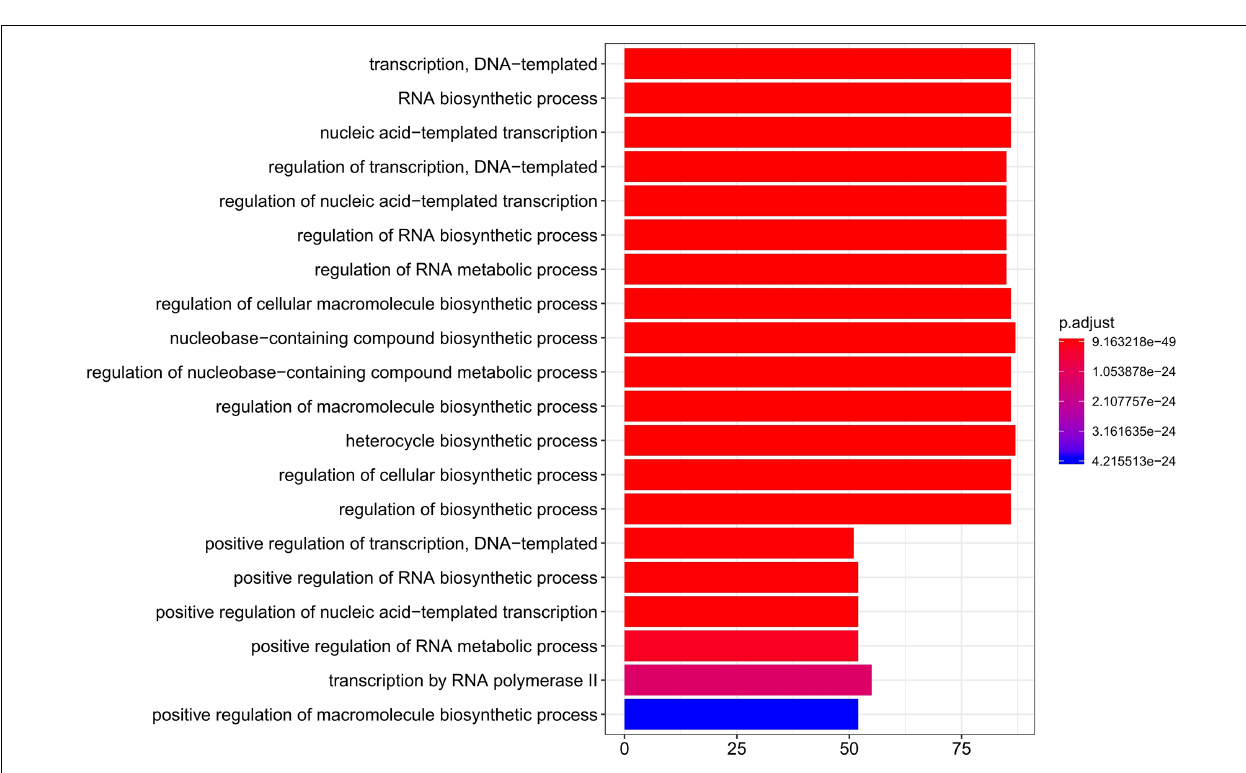
FIGURE 4 | Top 20 enriched GO terms for TFs of DDGs. GO, Gene Ontology; TFs, transcription factors; DDGs, developmental dynamics